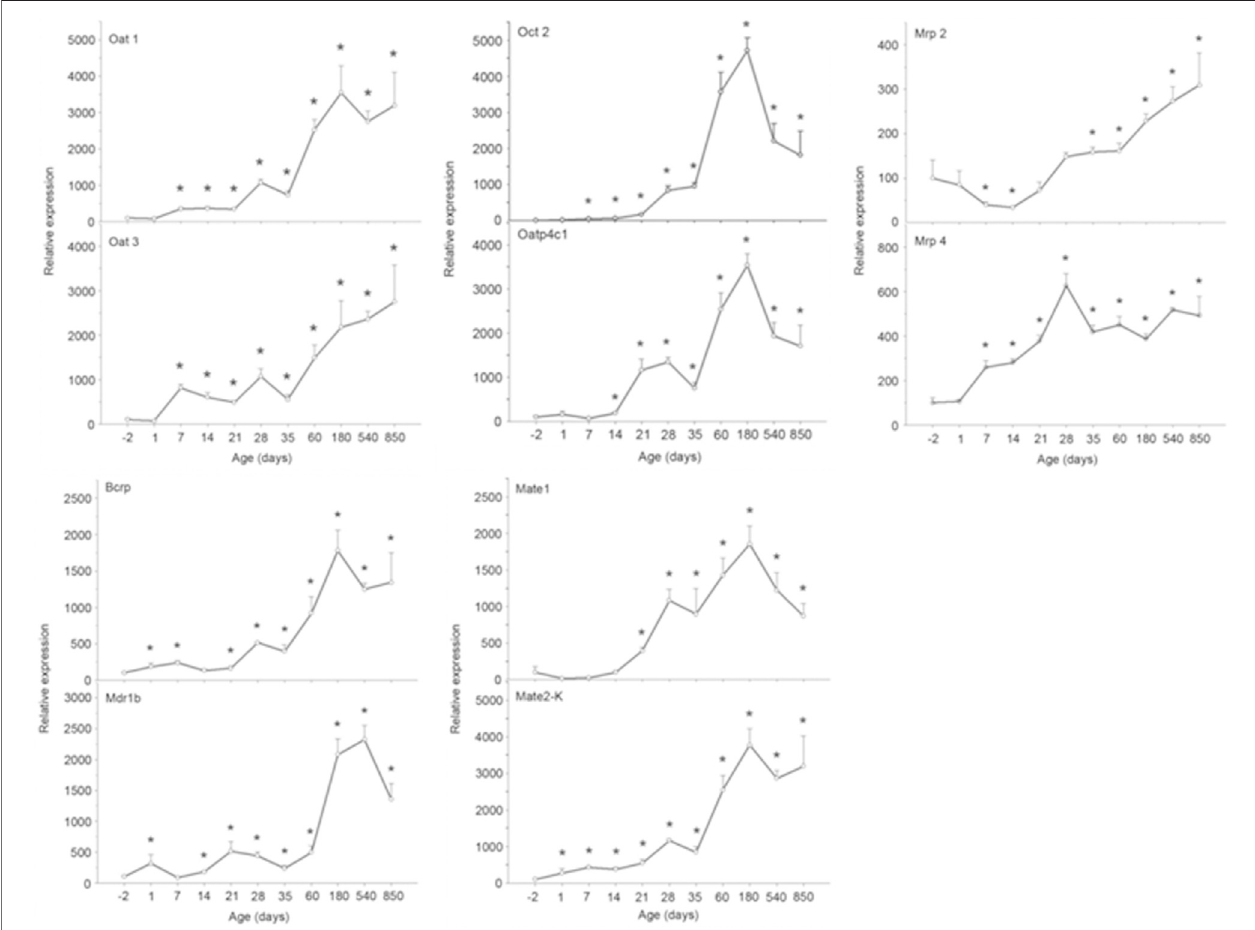
FIGURE2| The mRNA expressions of OAT1, OAT3, OATP4C1, OCT2, MDR1, BCRP, MATE1, MATE2-K, MRP2, and MRP4 in rat kidney at the − 2nd, 1st, 7th, 14th, 21st, 28th, 35th, 60th, 180th, 540th, and 850th day. Data are expressed as the mean ± standard error ( n (cid:1) 6). * p < 0.05 vs. the − 2nd day (Anderson,